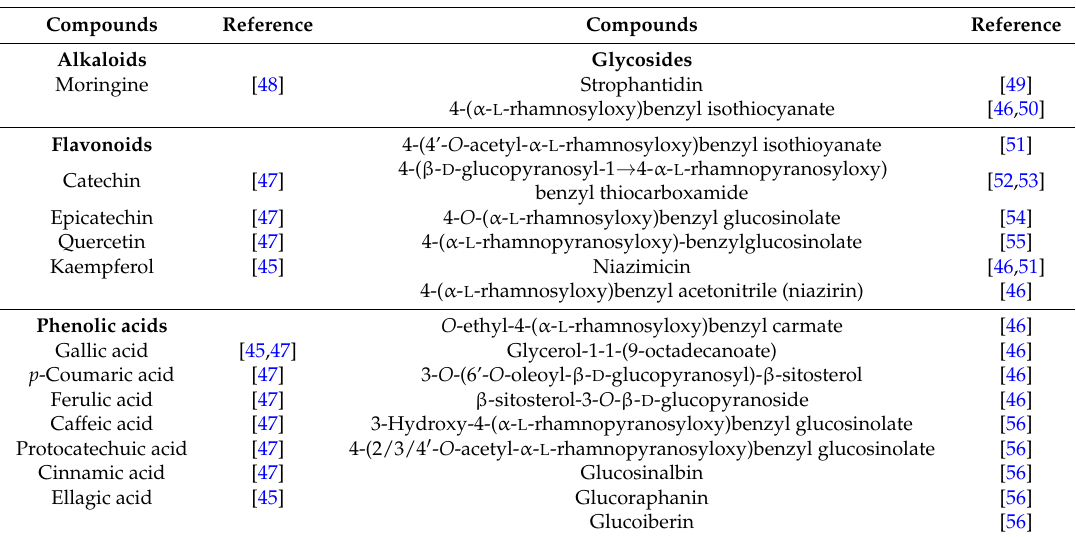
Table 6. Bioactive compounds in M. oleifera